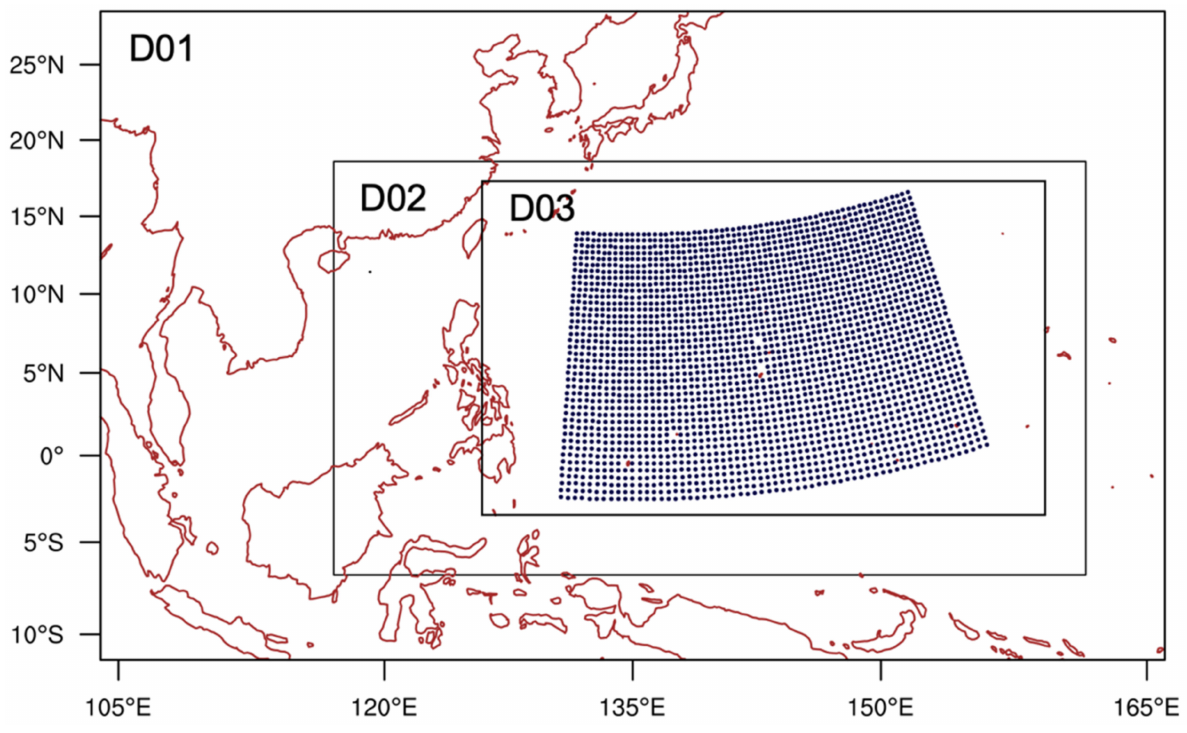
Figure 2. Triply nested model domains with 361 × 221 grid points in the 27-km resolution domain (D01), 763 × 421 grid points in the 9 km domain (D2), and 1420 × 922 grid points in the 3 km domain (D3) and MURON float distribution (black dots) for innermost domain (D03).